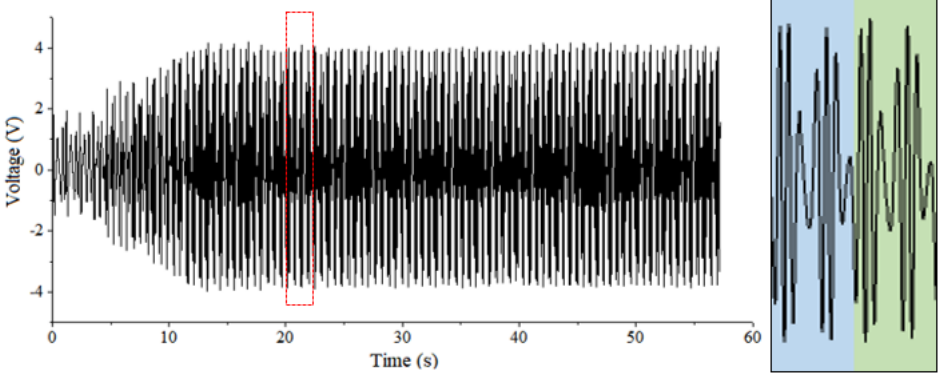
Figure 12. Voltage diagram (including the zoom-up of the enclosed region between 20.0 s and 22.3 s) under partial standing waves of T / T p = 1.0, h = 0.6 m (Reproduced from [35] with permission from Springer Nature).